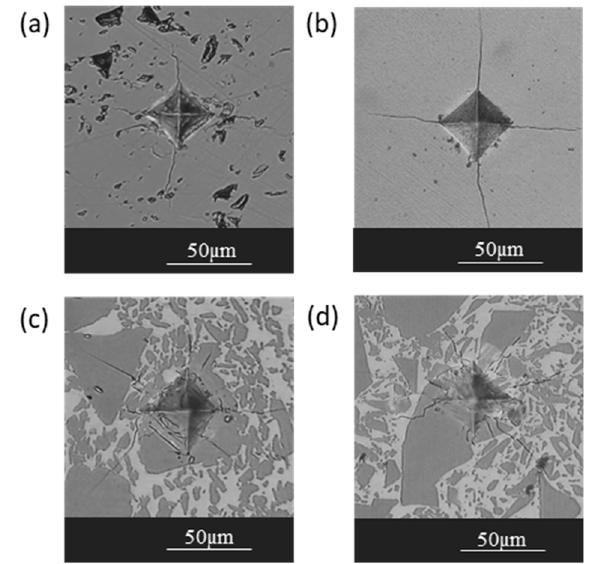
Figure 3. Marks left by Vickers indenter in the different materials. Detail of impressions: ( a ) pure Si, ( b ) Si-62 wt% Ir alloy, ( c ) SiC-Si composite material, and ( d ) SiC-Si-IrSi 3 composite material.